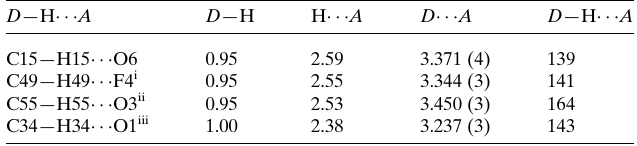
Table 6 Hydrogen-bond geometry (A˚ , (cid:4) ) for ( 3 ).